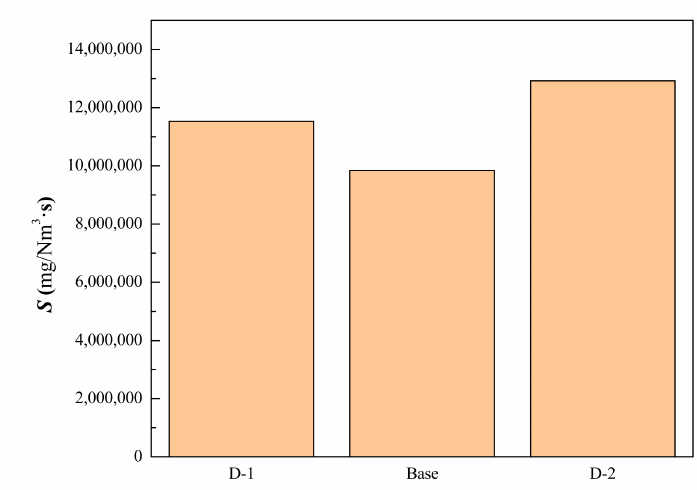
Figure 12. Influences of the negative fan pressure on CO emission. (The negative pressure: D-1 = − 11 kPa; Base = − 12 kPa; D-2 = − 13 kPa).